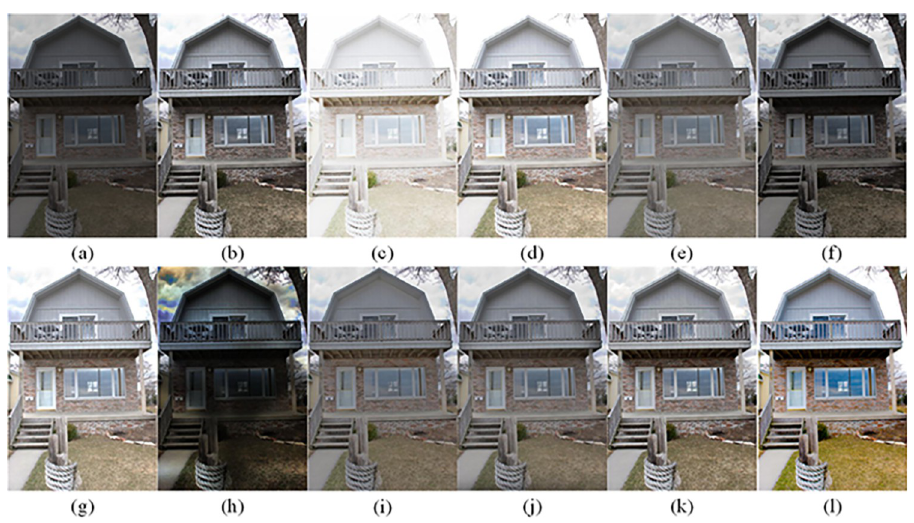
Fig 23. Comparisons of the ten algorithms in enhancing low-light image 13. (a) low-light image (b) AGCWD (c) Al-Ameen (d) BHE2PL (e) BIMEF (f) BPDHE (g) LIME (h) MSRCR (i) NPEA (j) SRIE (k) OURS (l) Normal light